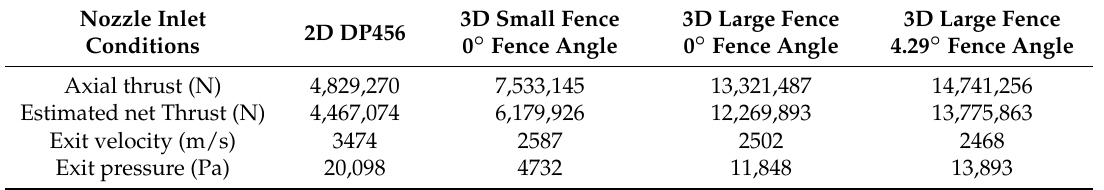
Figure 26. Mach contours and streamlines for SERN DP456 with the large side fence configuration at a 4.29° angle. Table 12. Performance comparison of different nozzle conditions at 100,00 ft. and Mach 8.